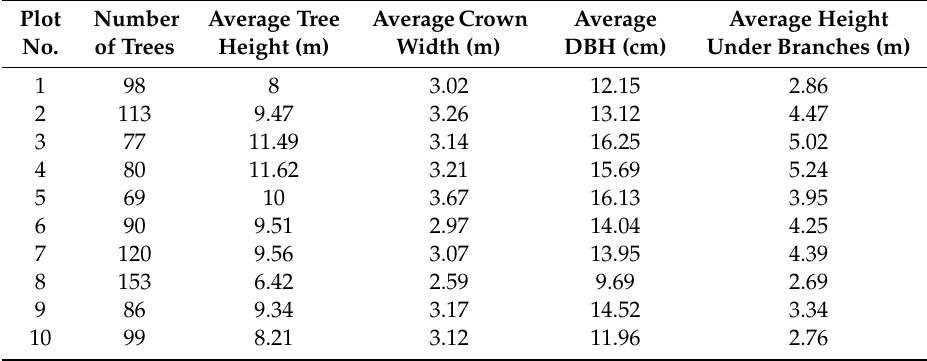
Table 2. Trees measurement in 16 investigated